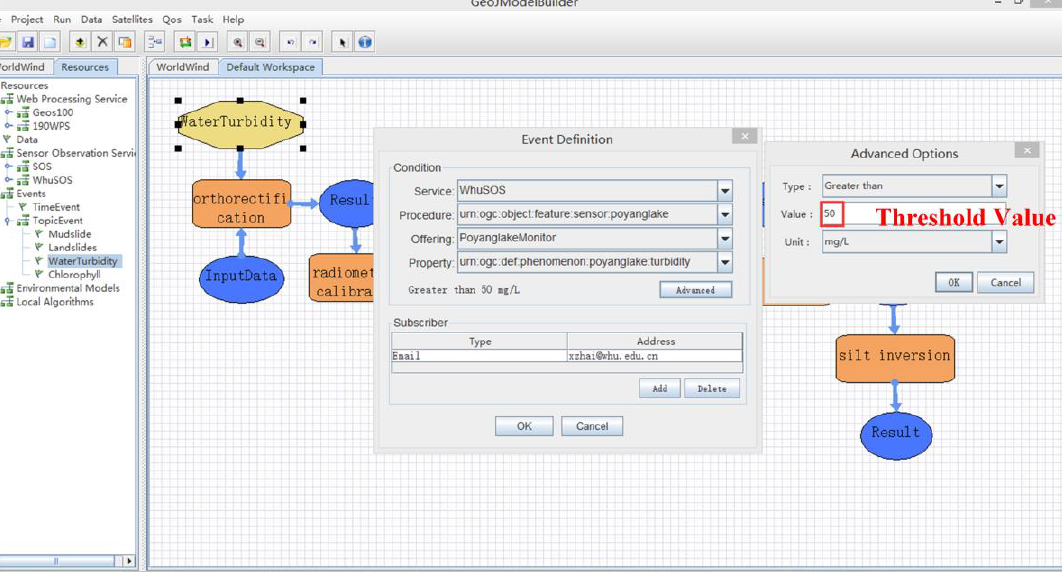
Figure 7. The graphical user interface for event subscription in the turbidity extraction case.